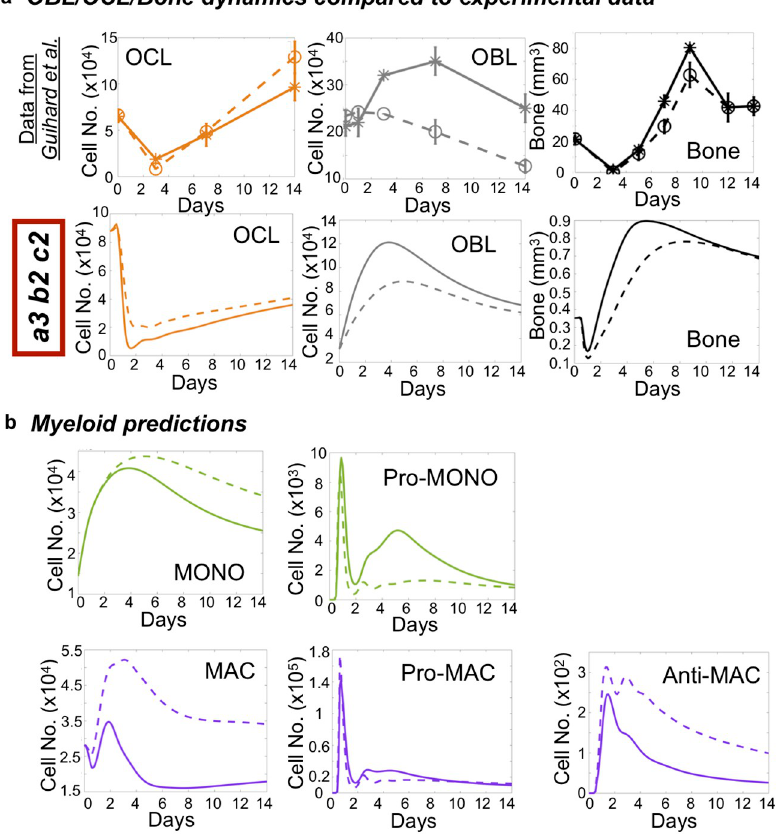
Fig 5. Bone repair dynamics in oncostatin M (OSM)-depleted bone predictions. a bone repair temporal data for OCL, OBL and bone, in presence or absence of OSM, is retrieved and plotted from a murine in vivo bone fracture healing study performed by Guihard P , et al [49]. on the top panel (solid line = WT, dashed line = OSM-null; http:// doi.org/10.1016/j.ajpath.2014.11.008). Reduction in OBL bone formation rate and mineralization activity, allow model to qualitatively reproduce OBL, OCL and bone dynamics in OSM-null dataset (lower panel; solid line = unmodulated, dashed line = OSM -/- ). b. corresponding Myeloid populations predictions with reduced OBL formation rate and mineralization activity (lower panel; solid line = unmodulated, dashed line = OSM -/- ), for which no data was available in Guihard P , et al [49]. Simulations were obtained with model a2-b2-c1 , calibrated on the injury data (Fig 4) through J 1